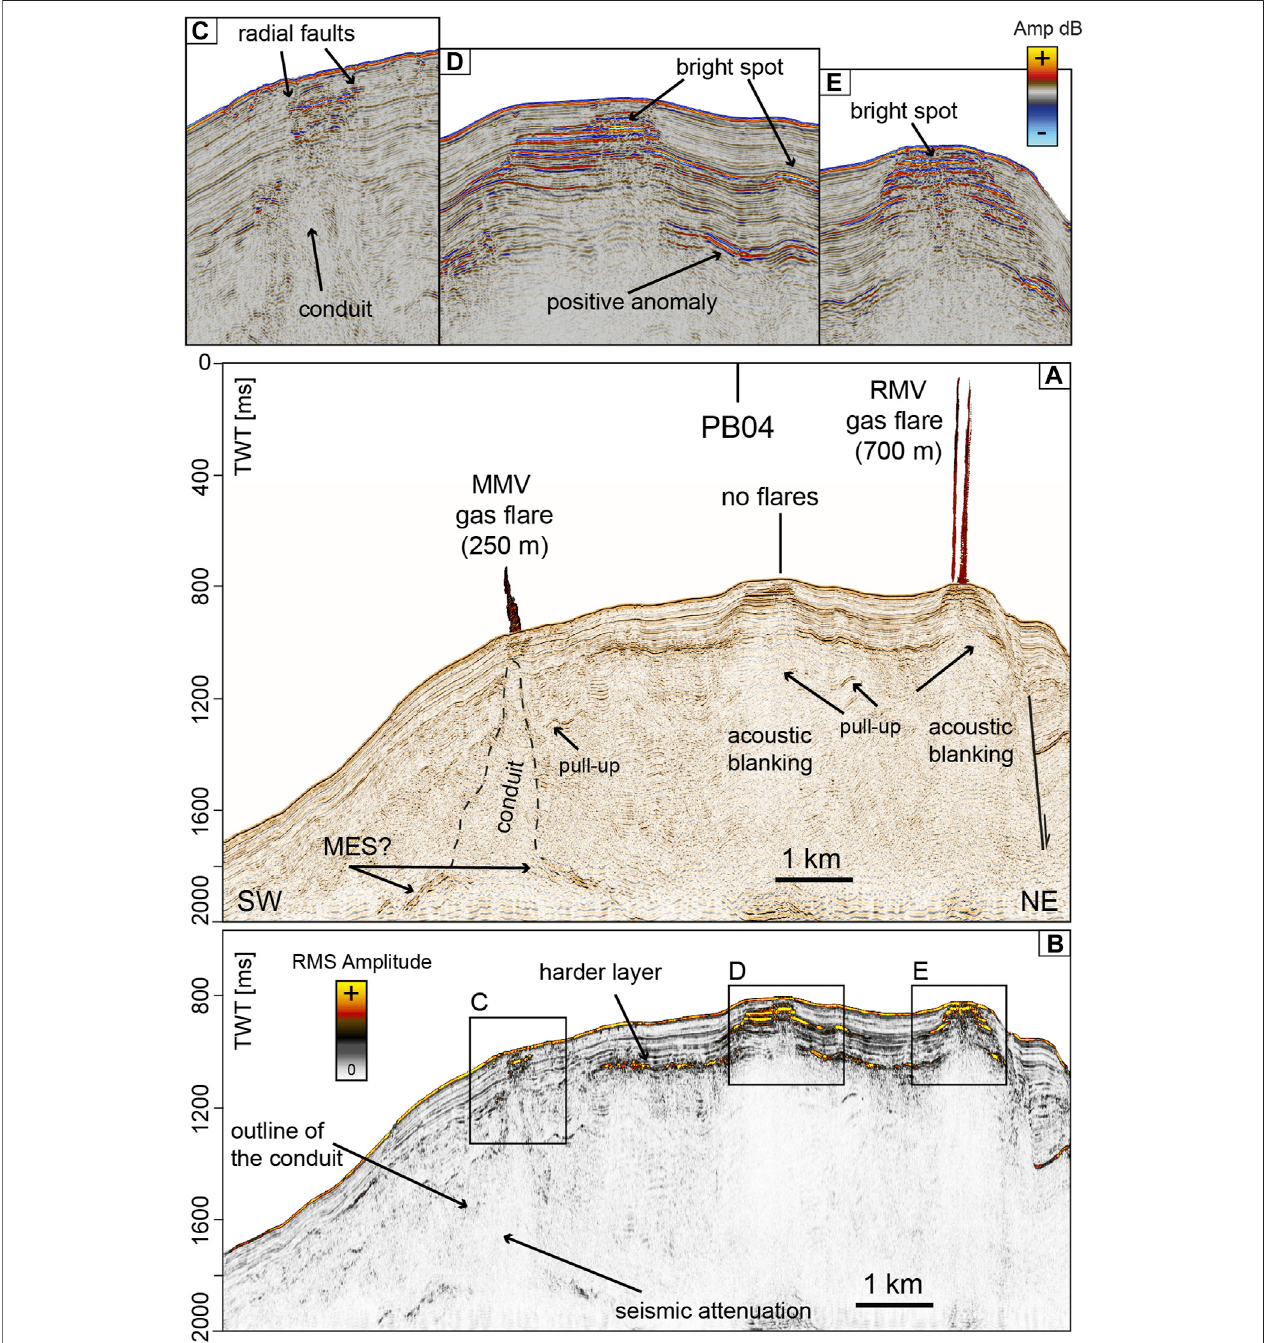
FIGURE 8 | (A) Seismic re fl ection pro fi le PB06A passing above RMV and MMV where gas fl ares have been detected. (B) RMS Iterative amplitude extracted from thewholepro fi lehighlightingacontinuousre fl ectionconnectedtoanimpedanceacousticcontrastduetoaharderlayerlocated100 – 150 mbelowtheseabed.Close-up panels of seismic in correspondence of: (C) MMV; (D) the mounded structure not connected to gas fl ares; (E) RMV. Location in Figure 2A .